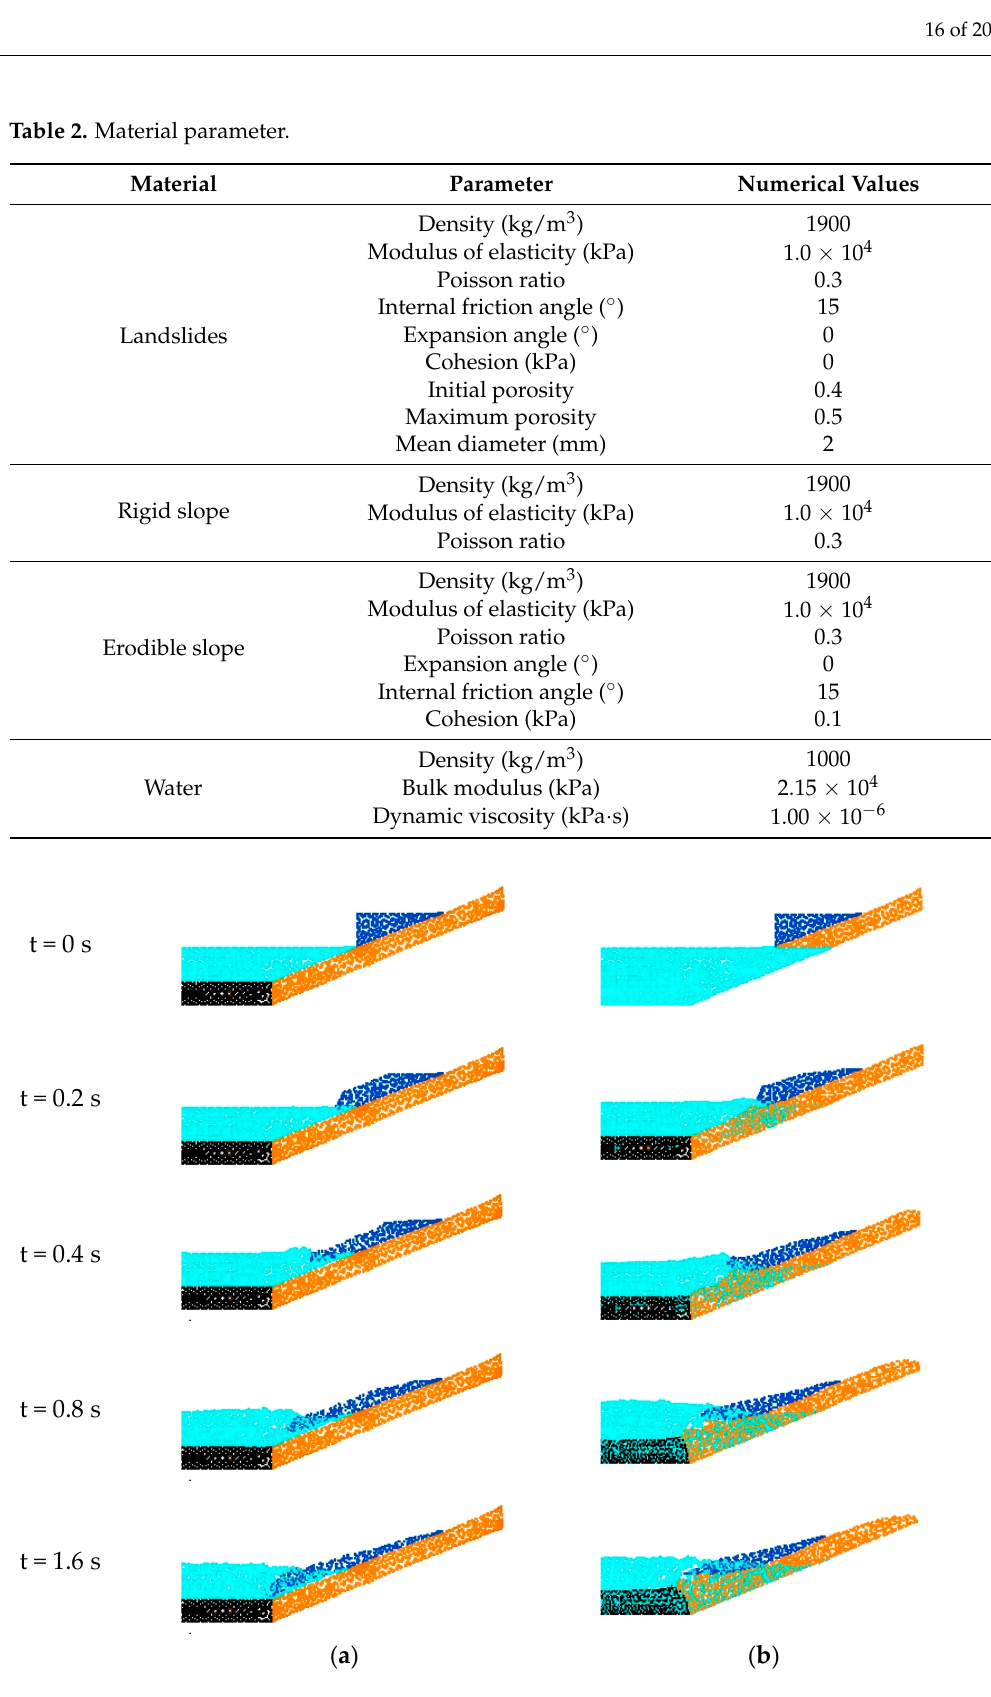
Figure 16. Snapshots of the landslide process of dry particles at different moments on ( a ) rigid slopes; and ( b ) erodible